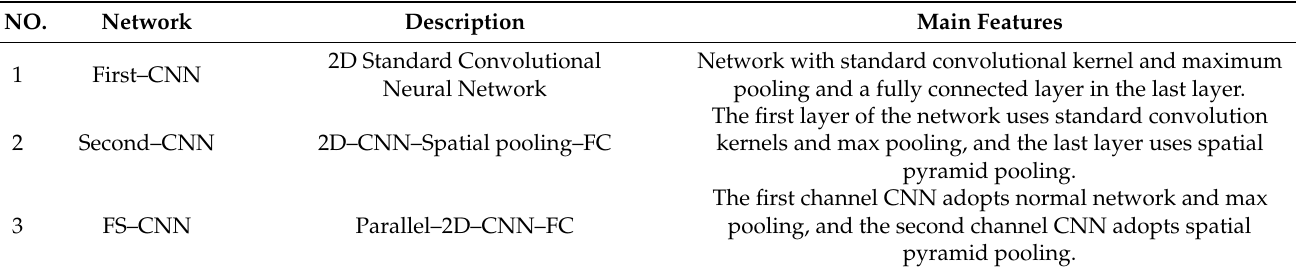
Table 2. Description of the different model structures.